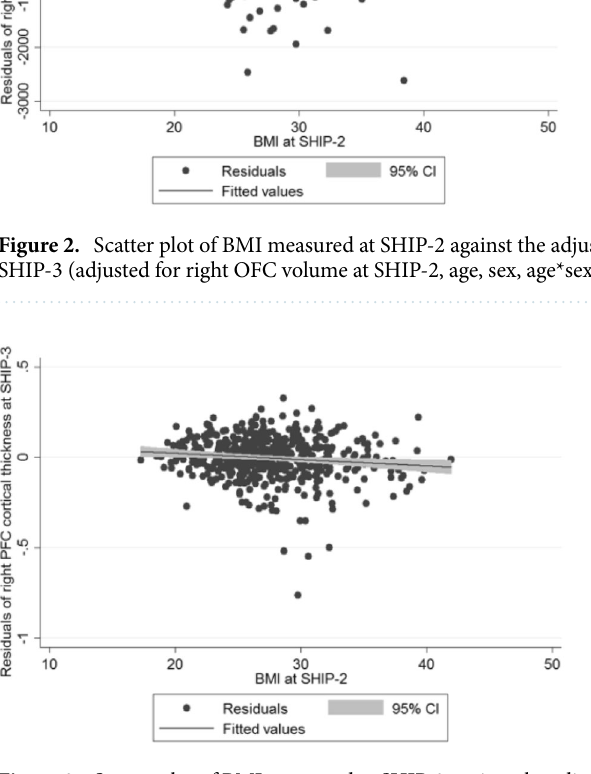
Figure 3. Scatter plot of BMI measured at SHIP-2 against the adjusted residuals for right AC-MPFC mean cortical thickness at SHIP-3 (adjusted for right AC-MPFC mean cortical thickness at SHIP-2, age, sex, age*sex interaction, ICV, follow-up